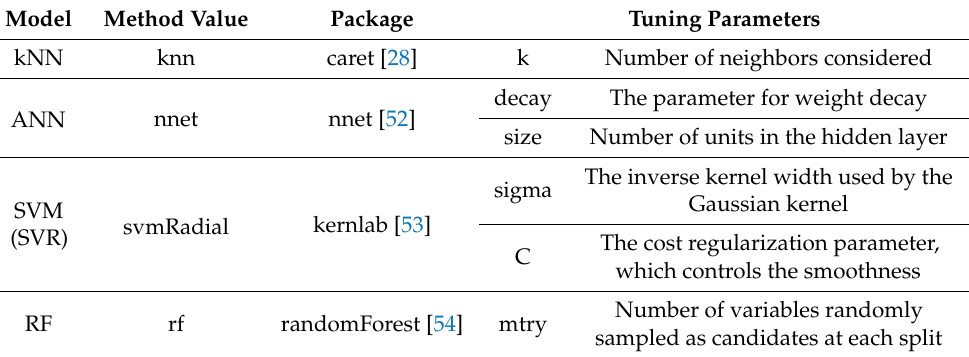
Table A1. Hyperparameters to be tuned in the four ML methods used in this study.